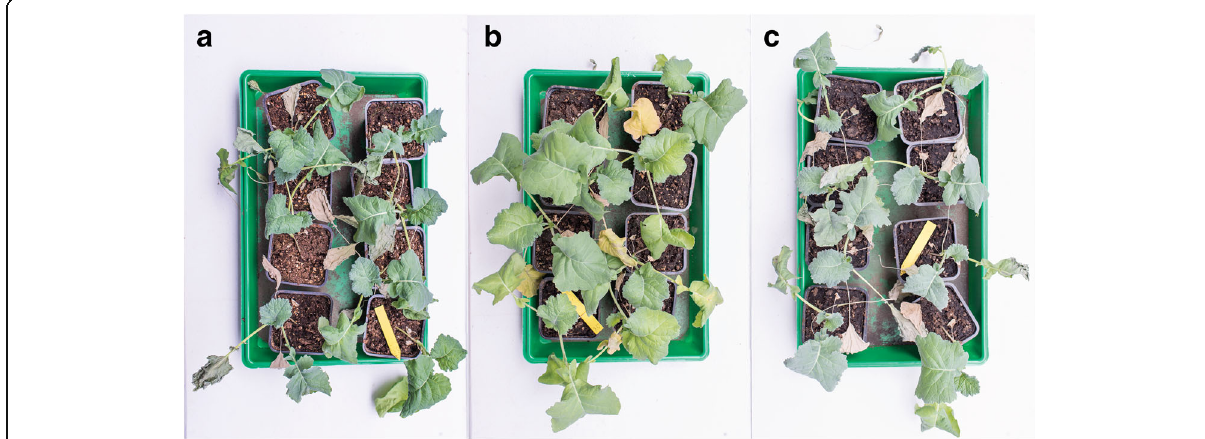
Fig. 4 Photos of plants after rewatering after 5 days of drought stress. a Control plants irrigated with nutrient solution. b Plants irrigated with nutrient solution containing 0.8 mg/ml IONs. c Plants irrigated with nutrient solution containing 2 mg/ml IONs